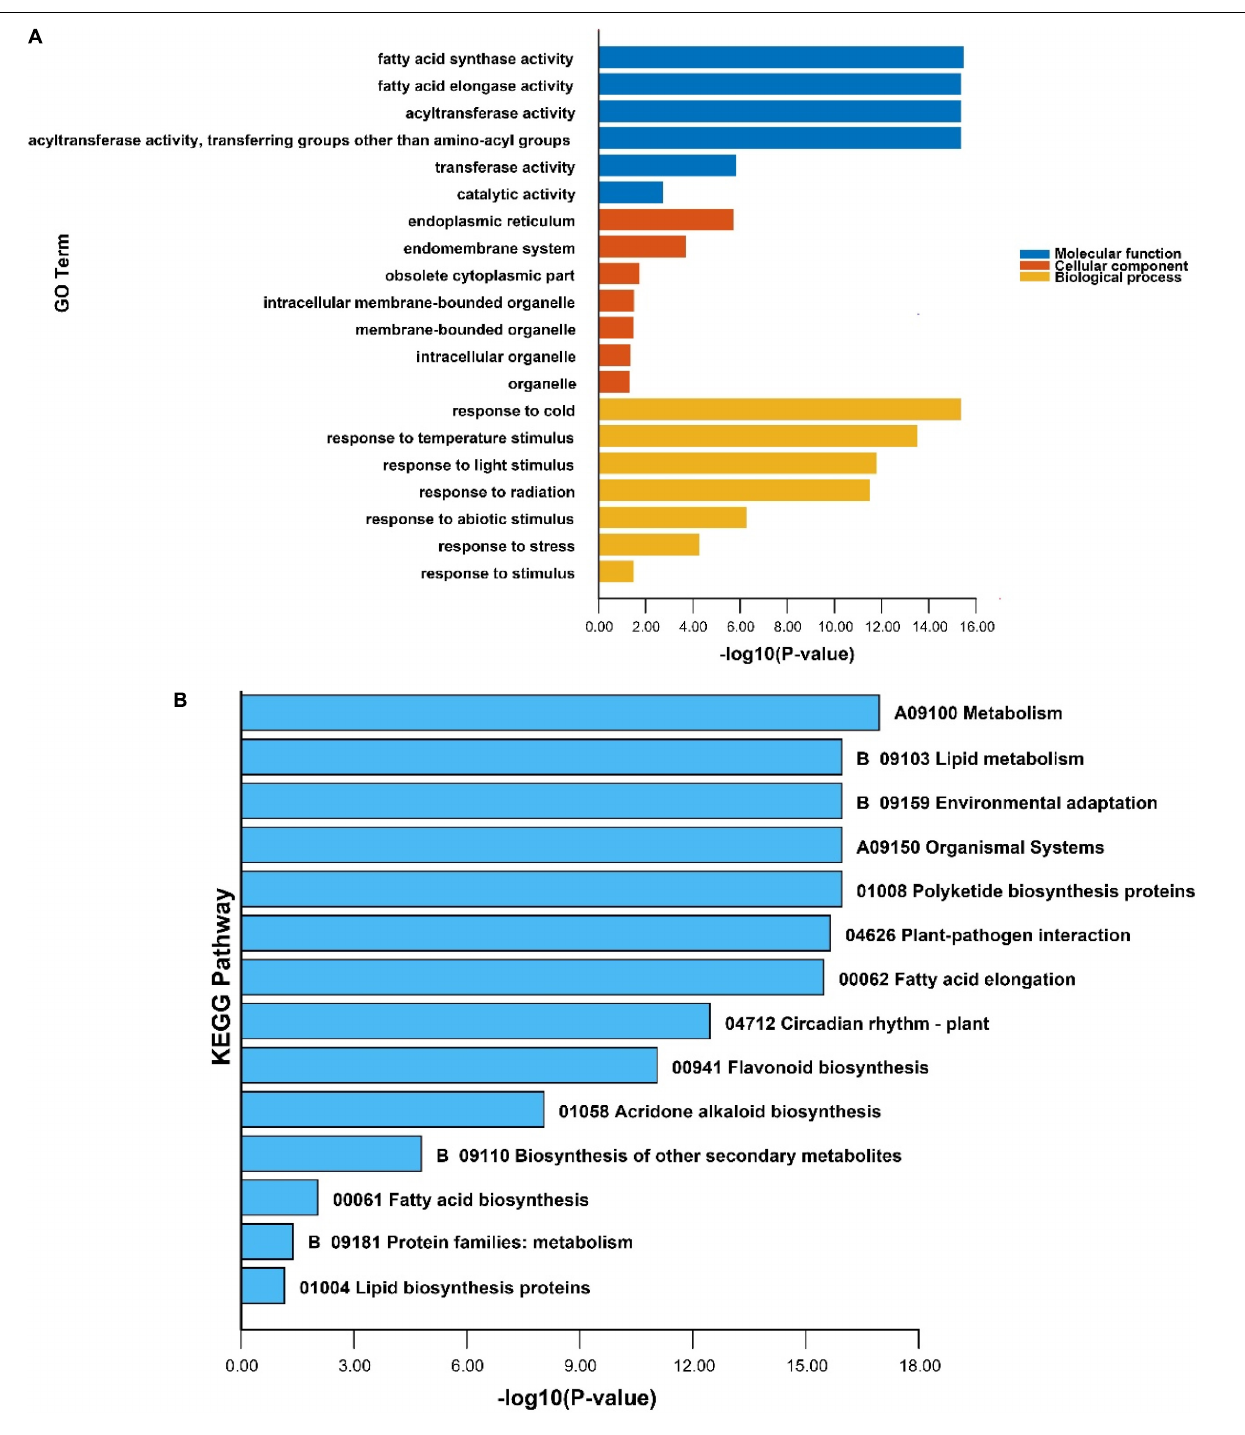
genes ( PeKCS 17, PeKCS 19, PeKCS 21, PeKCS 22, and PeKCS 28) decreased during fruitlet (FPKM = 69.22, 24.43, 13.16, 14.11, and 20.59) to ripening stages (FPKM = 2.77, 0.6, 3.72, 3.6, and